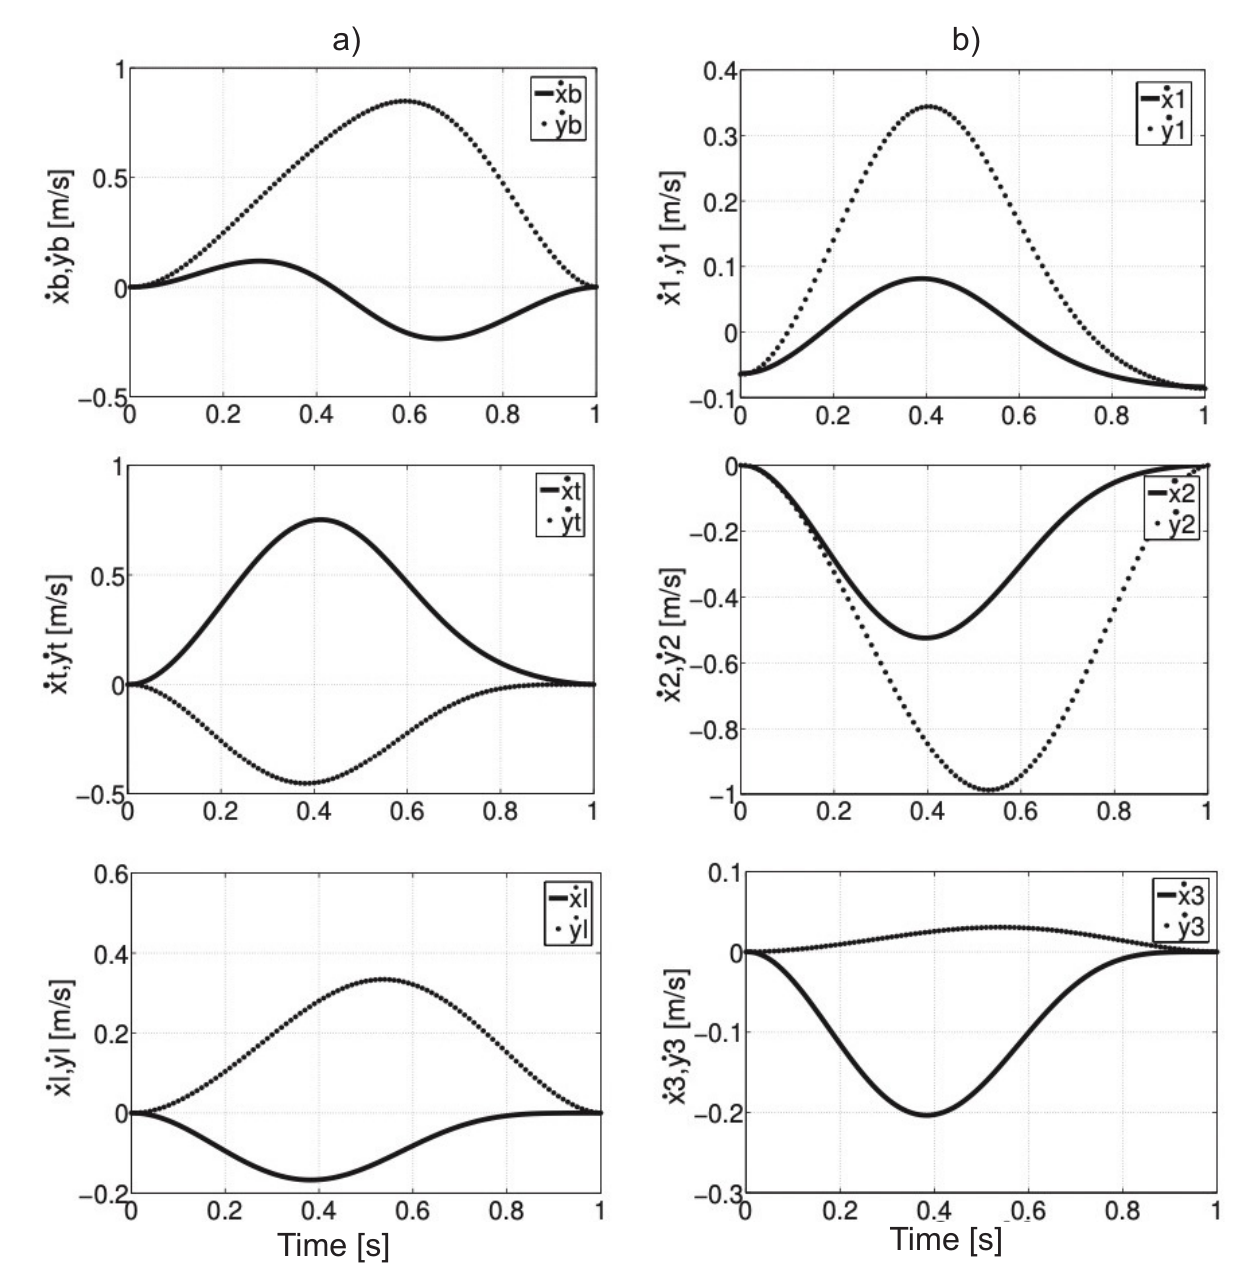
Figure 3. The velocity of the mass center of the trunk, thigh, and shank on x - and y -axis ( a ), the velocity of the mass center of actuators 1, 2, 3 ( b